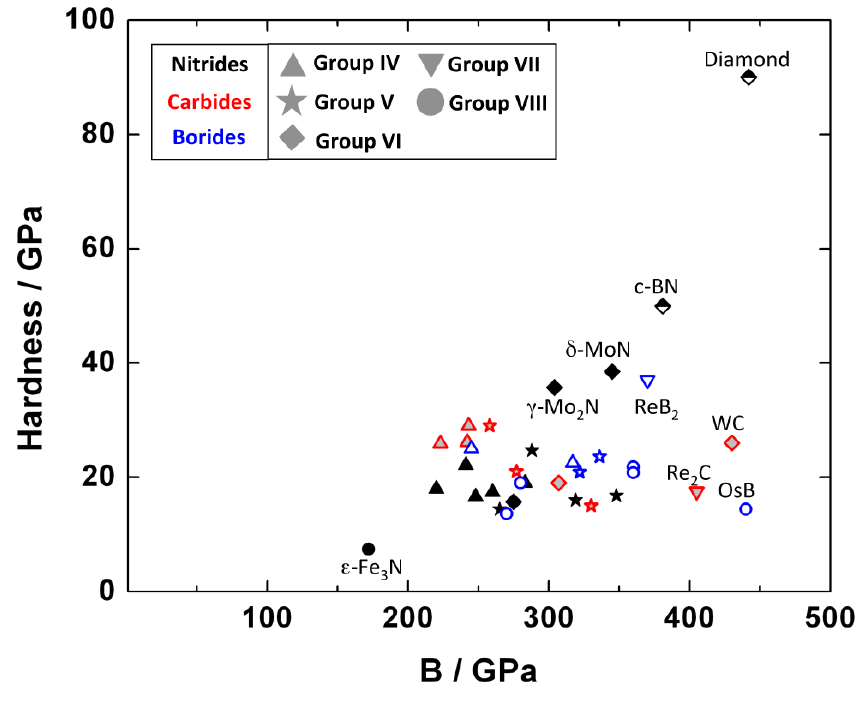
Figure 24. Plot of the hardness versus bulk modulus of various binary transition metal carbides, nitrides and borides in comparison with cubic BN and